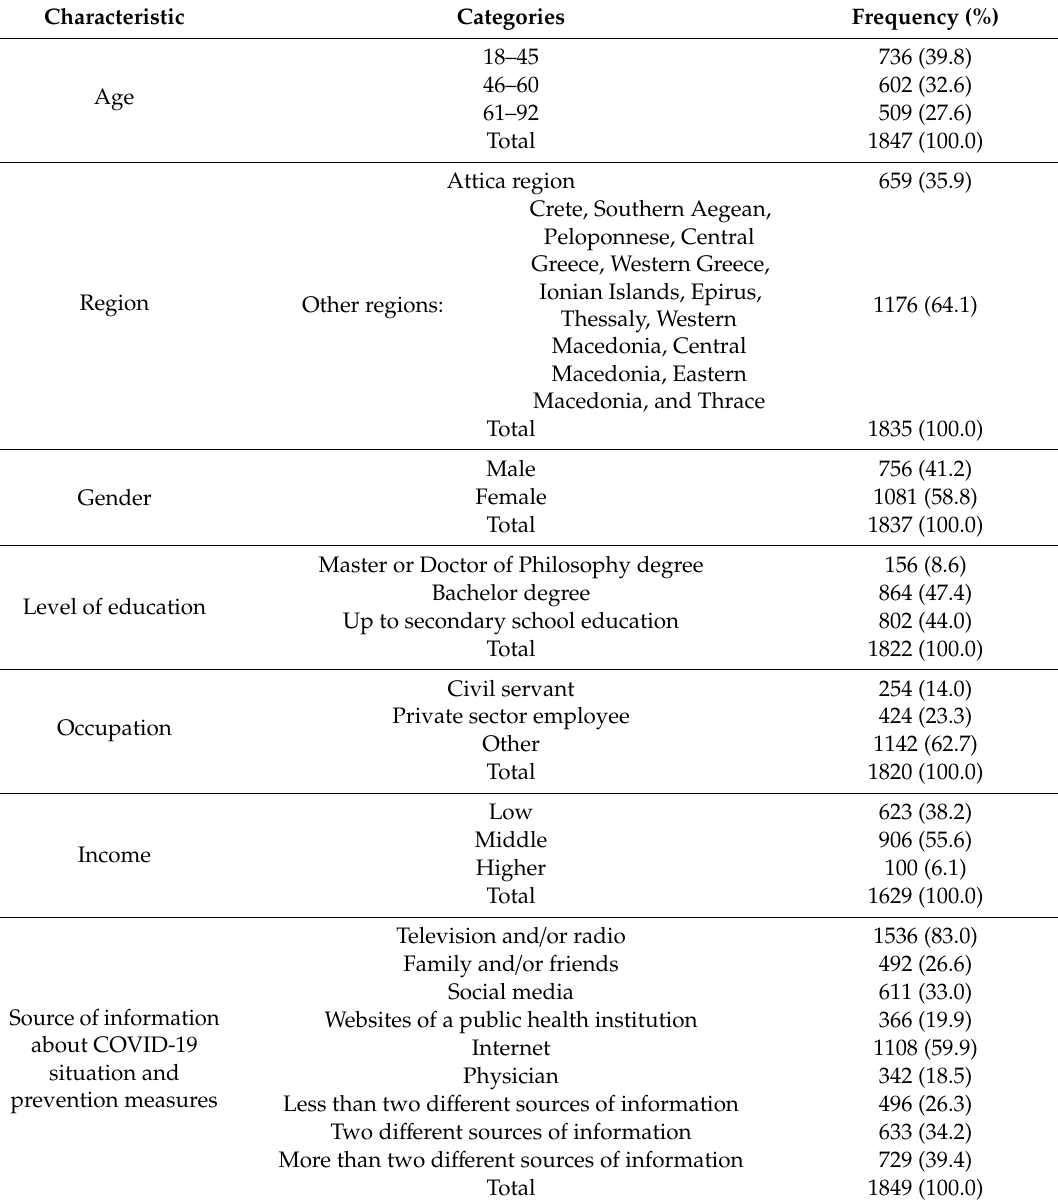
Table 2. Demographic characteristics of respondents and source of information about coronavirus disease 2019